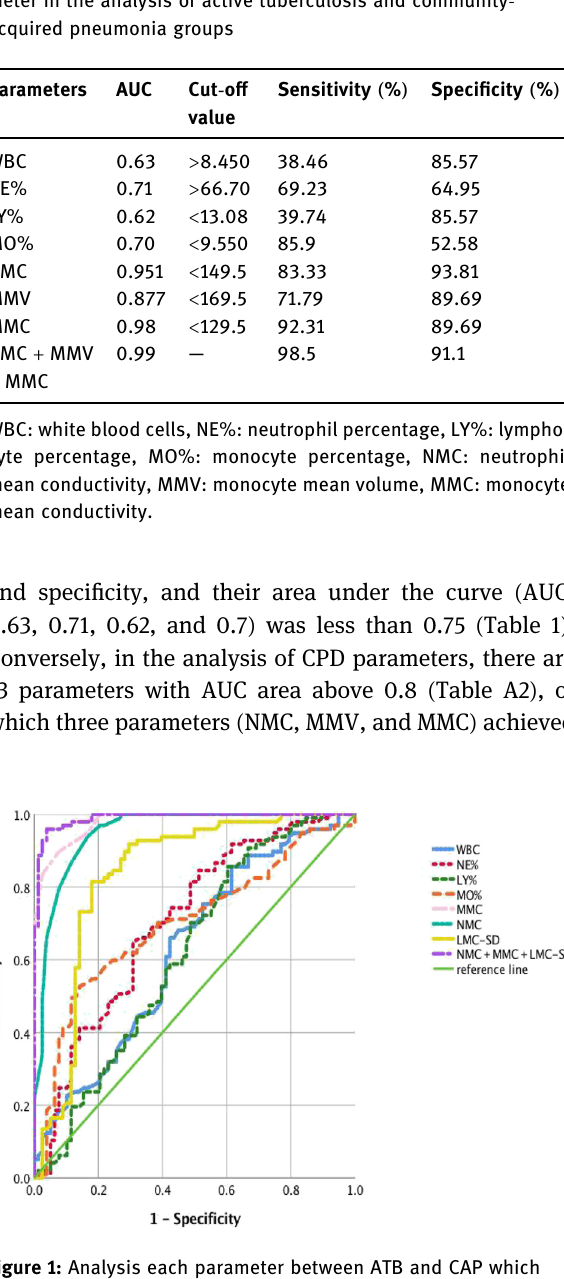
Table 1: Sensitivity and speci fi city of cut - o ff values for each para - meter in the analysis of active tuberculosis and community - acquired pneumonia groups